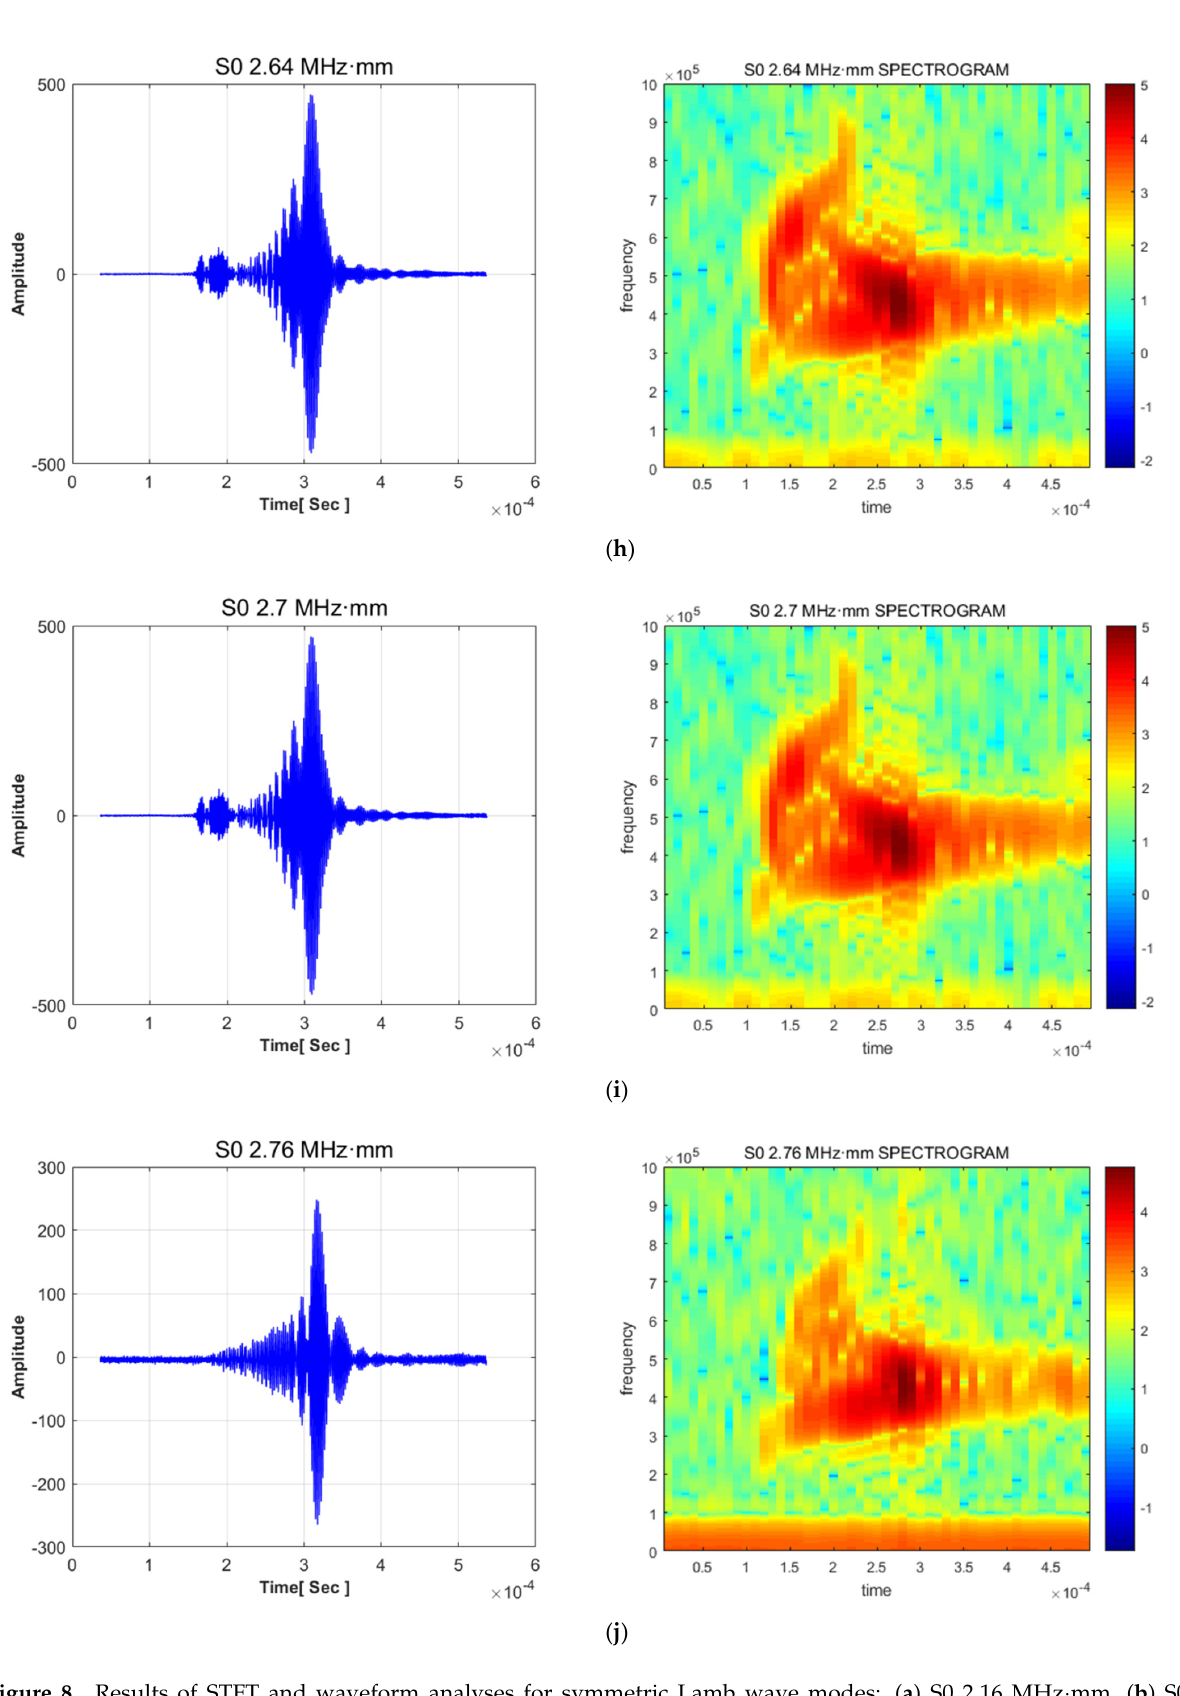
Figure 8. Results of STFT and waveform analyses for symmetric Lamb wave modes: ( a ) S0 2.16 MHz · mm, ( b ) S0 2.22 MHz · mm, ( c ) S0 2.28 MHz · mm, ( d ) S0 2.34 MHz · mm, ( e ) S0 2.40 MHz · mm, ( f ) S0 2.46 MHz · mm, ( g ) S0 2.52 MHz · mm, ( h ) S0 2.64 MHz · mm, ( i ) S0 2.70 MHz · mm, and ( j ) S0 2.76 MHz ·